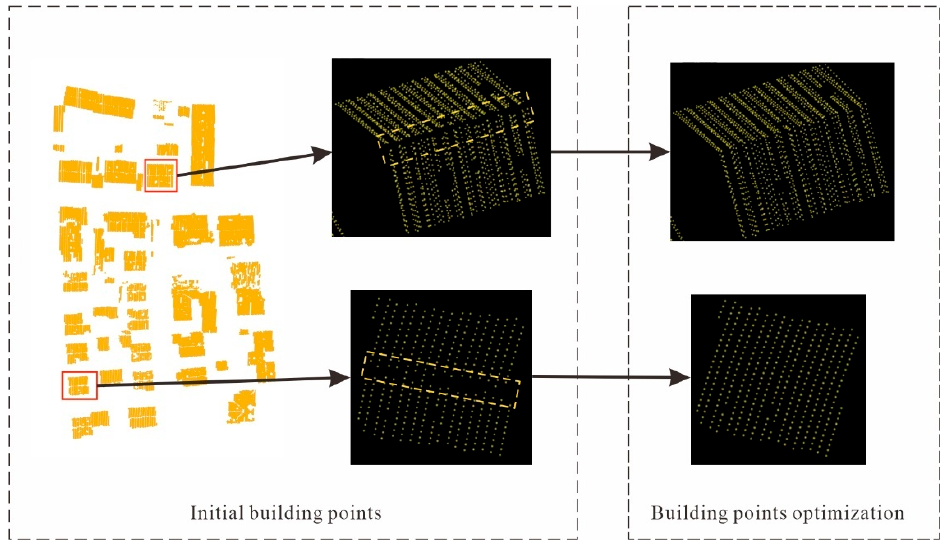
Figure 3. Building points optimization.